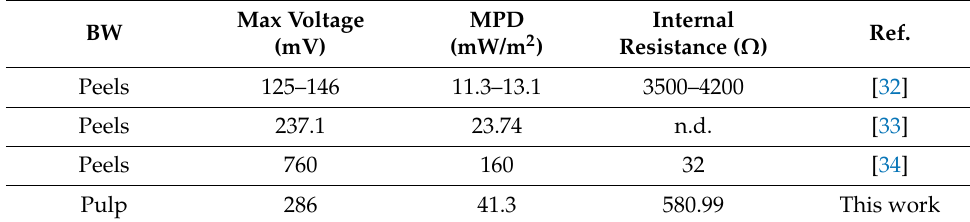
Table 3. MPD, max voltage, and internal resistance reported by previous